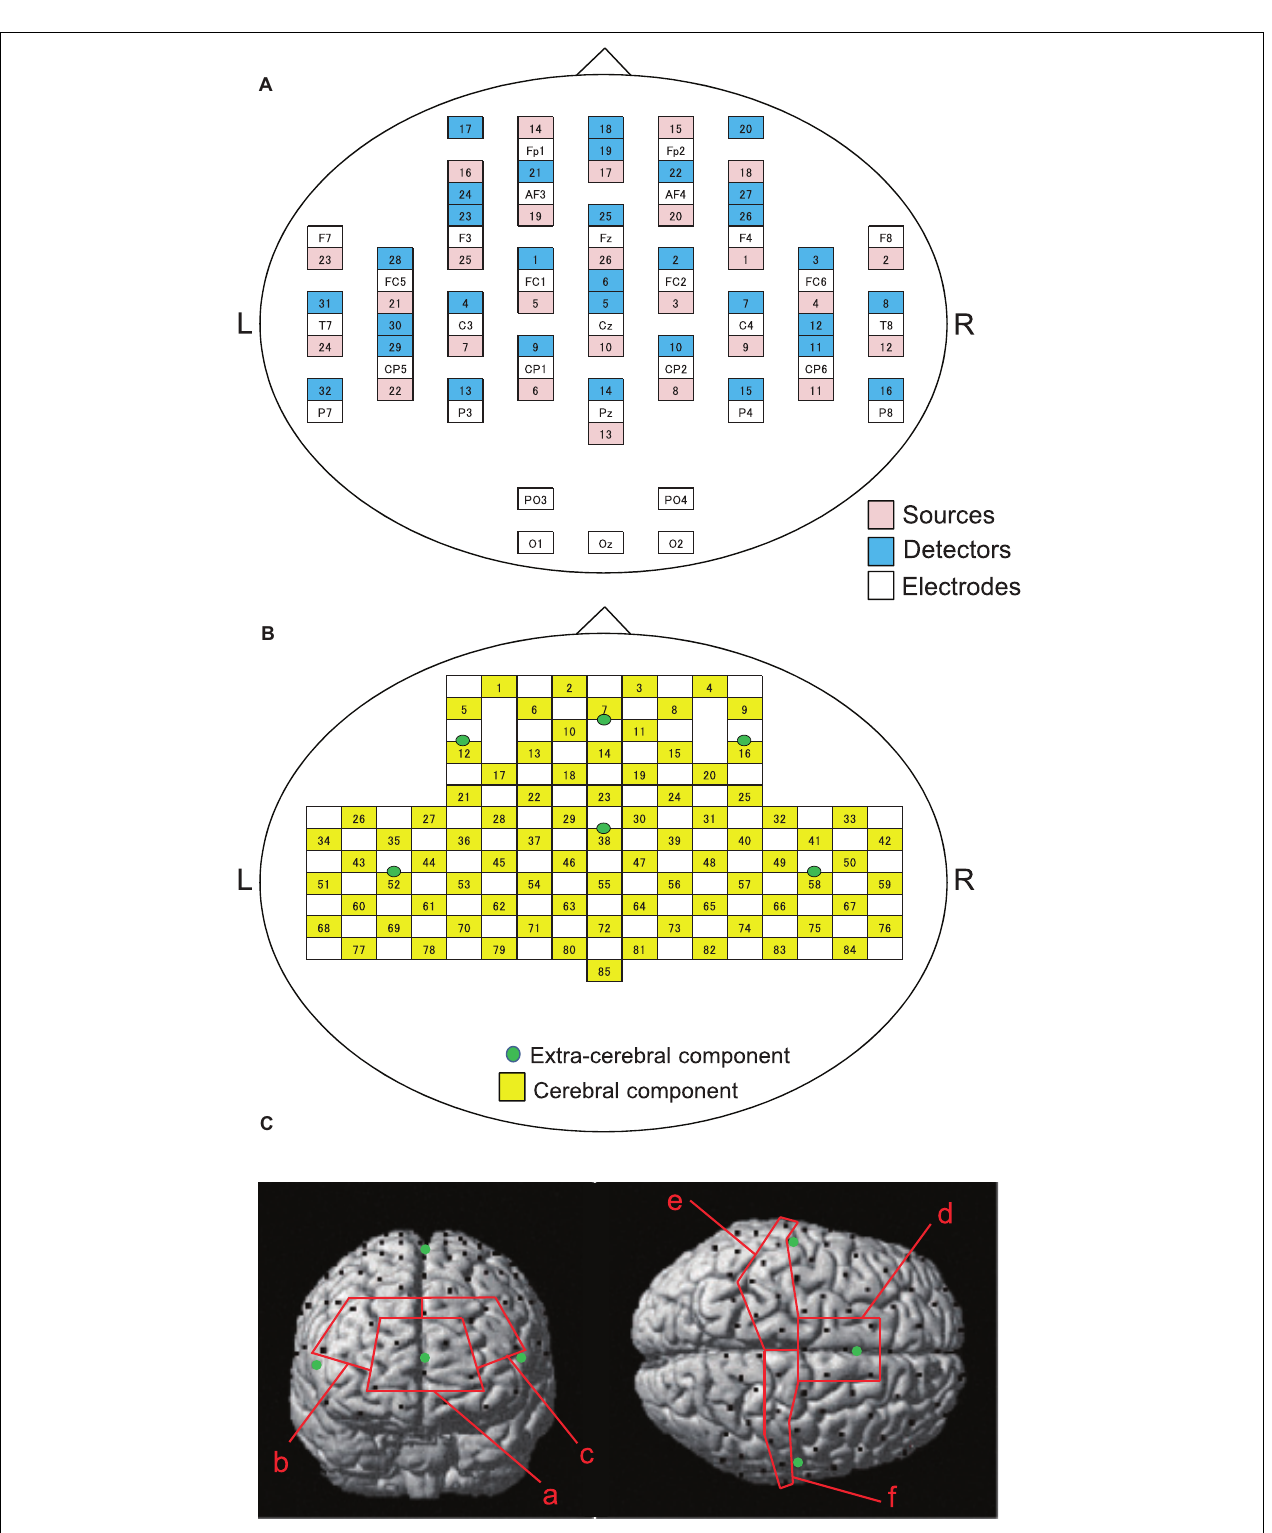
FIGURE 2 | Arrangements of NIRS probes and EEG electrodes. (A) Arrangement of NIRS probes (source and detectors) and EEG electrodes. (B) Locations of NIRS channels. Green cycles indicate extra-cerebral component channels. (C) Spatial registration of NIRS channel locations. Black circles, NIRS channels; green circles, extra-cerebral component channels. (a) frontal polar area in the prefrontal cortex (pPFC); (b) right dorsolateral prefrontal cortex (R-dlPFC); (c) left dorsolateral prefrontal cortex (L-dlPFC); (d) supplementary motor area (SMA); (e) left primary sensorimotor cortex (L-SMC); (f) right primary sensorimotor cortex (R-SMC).